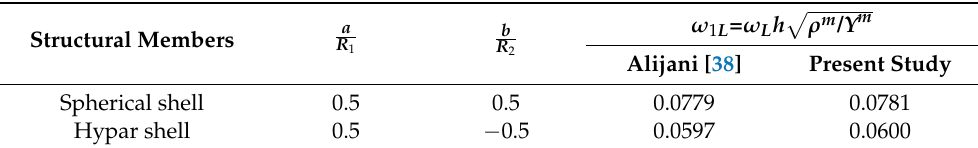
Table 1. Comparative evaluation with the literature of ω 1 L for different shallow structural members made of an isotropic material.